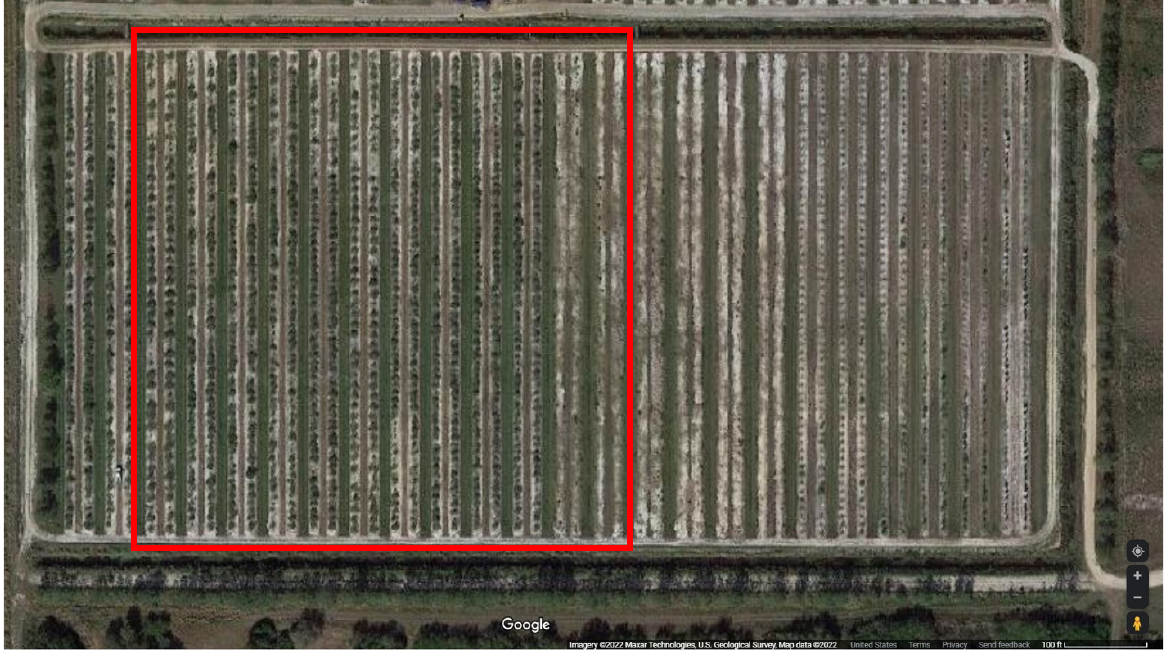
Figure 6. Satellite image of the area in which the study was conducted. The experimental grove from which the grapefruit trees were excavated is highlighted in red. The grapefruit grove is located at the University of Florida, Institute of Food and Agricultural Sciences (UF/IFAS), Indian River Re- search and Education Center (IRREC) located in Fort Pierce, Florida, USA. Image was acquired from Google Maps on 16 November